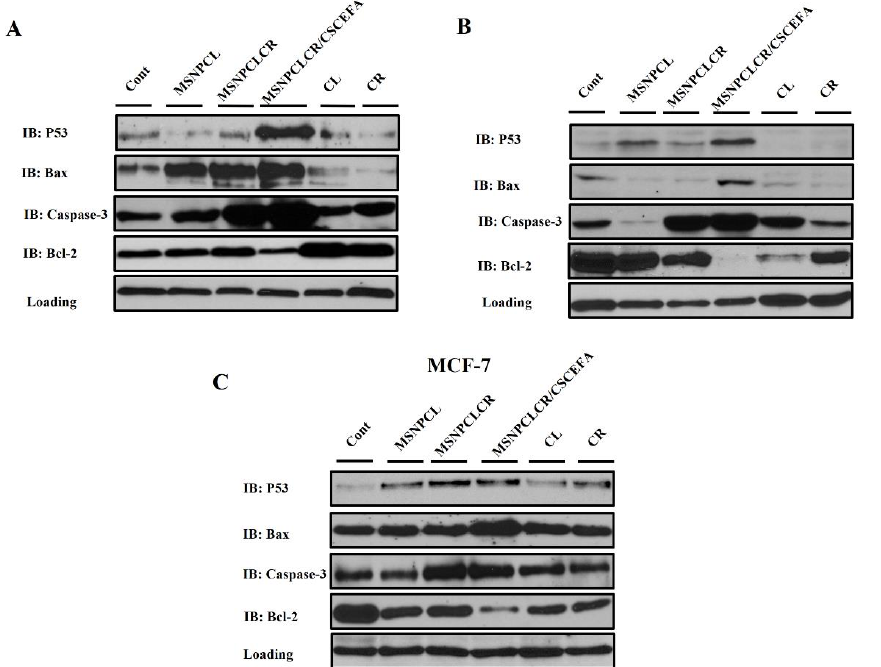
Figure 10. Western blot analysis of p53, caspase-3, Bax, and Bcl-2 markers of apoptosis for nanofor- mulations compared with free CL and CR against HOS cancer cells treated at the IC50 concentration (µg/mL) of each formulation by incubation for 72 h. The concentration was prepared for nanofor- mulations as an equivalent concentration of CL and CR in nanoformulation equal to free CL and CR. ( A ) western blot analysis for HCT-116 cancer cells; ( B ) western blot analysis for HOS cancer cells; ( C ) western blot analysis for MCF-7 cancer cells.